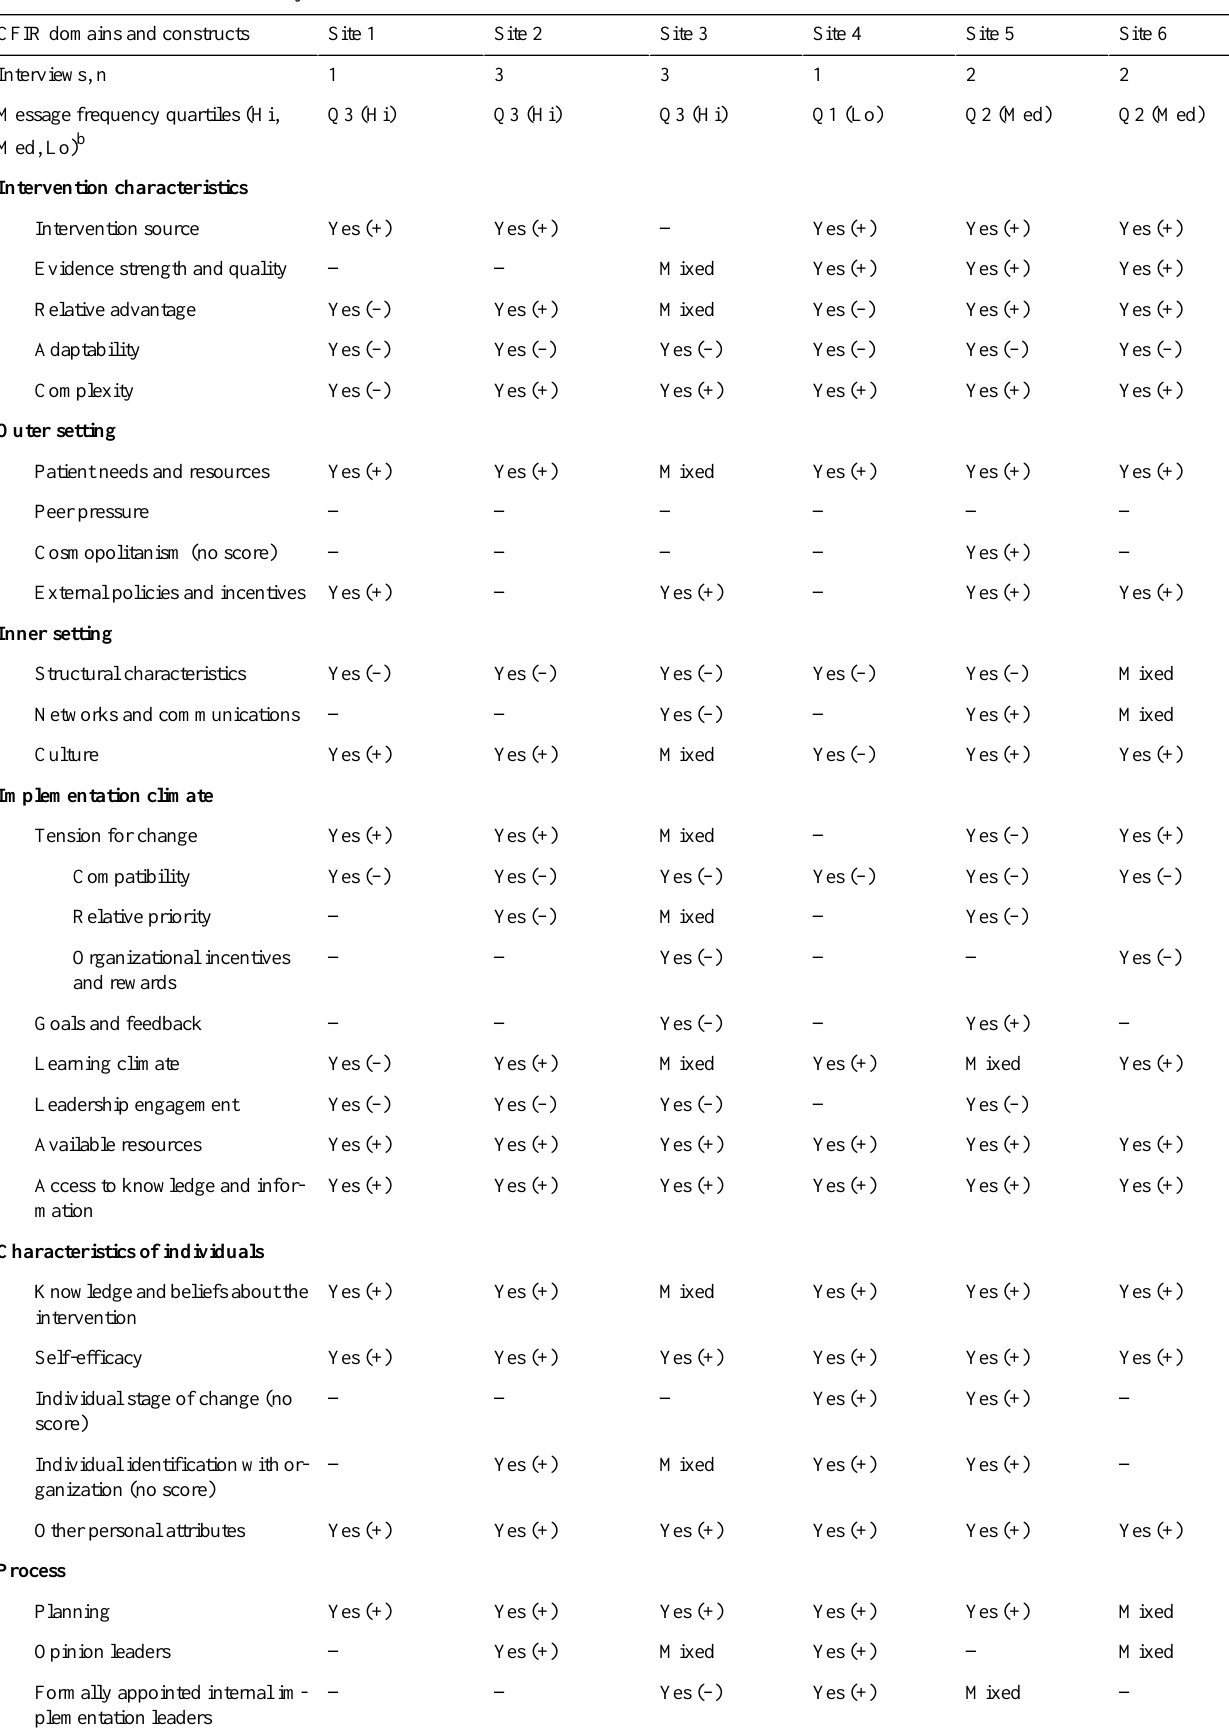
Table 6. Salient CFIR a constructs by